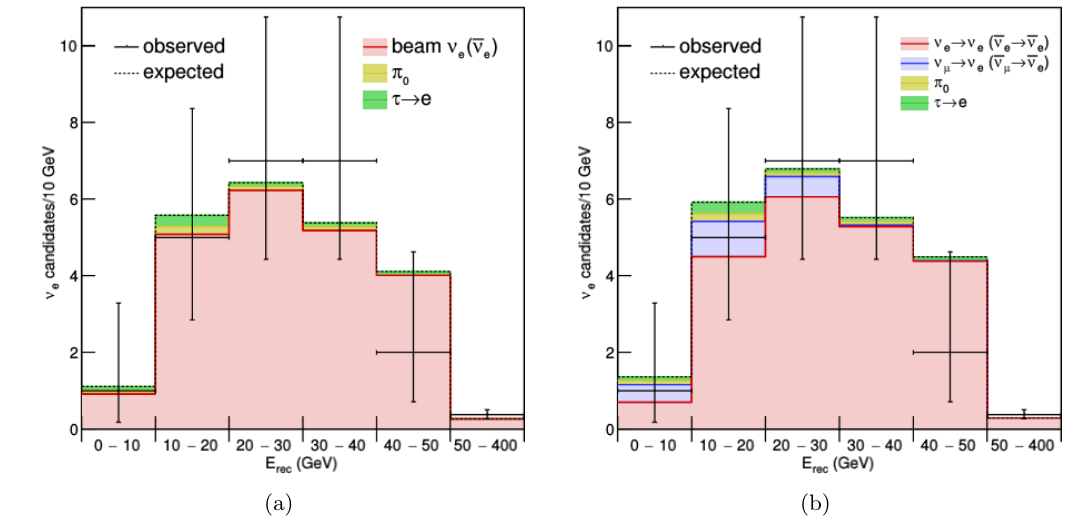
Figure 3 . The reconstructed energy distributions of the observed (cid:23) e candidates, the expected background and beam (cid:23) e and (cid:22) (cid:23) e components: (a) assuming no oscillations; (b) in case of 3 neutrino (cid:13)avour mixing with the parameters from